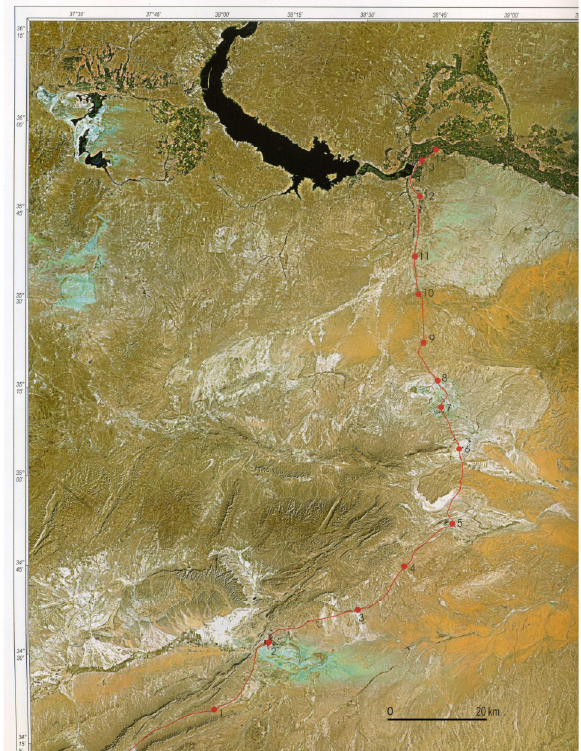
Figure 2. The Strata Diocletiana. A satellite map illustrating sites on the Strata Diocletiana passing Jebel Bishri: 1. Kh. al- Hallabat, 2. Palmyra, 3. Araq, 4. Helela, 5. Sukhne, 6. Oriza (Taibe), 7. El Kowm, 8. Qdeir, 9. Tell al-Fhada, 10. Holle, 11. Resafa-Sergiopolis, 12. Qusair al-Saila, 13. Sura I and 14. Sura II. Courtesy: GORS (SAS 2002).